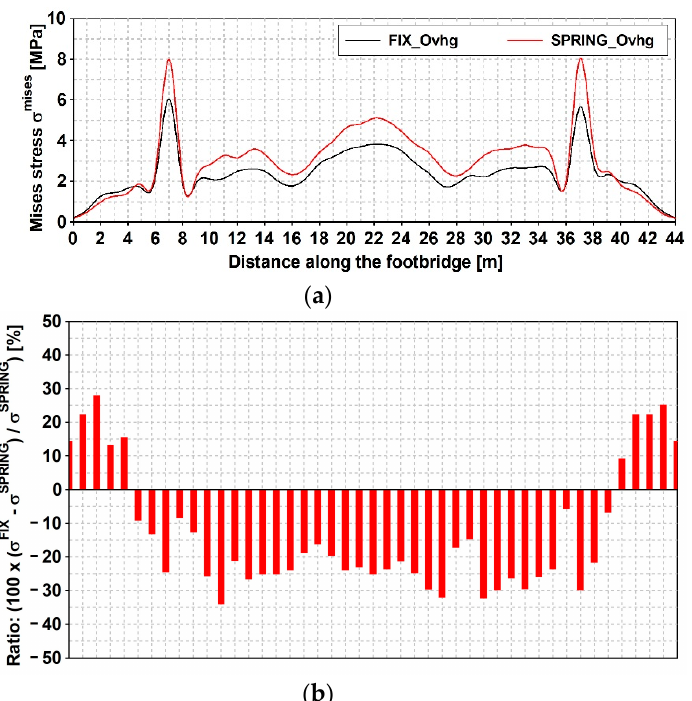
Figure 24. Mining induced stress [MPa] time histories: event with wide band spectrum; von Mises stress along the span, at the bottom flange: ( a ) FIX_Ovhg (black line) and PRING_Ovhg model (red line); ( b ) percentage error.